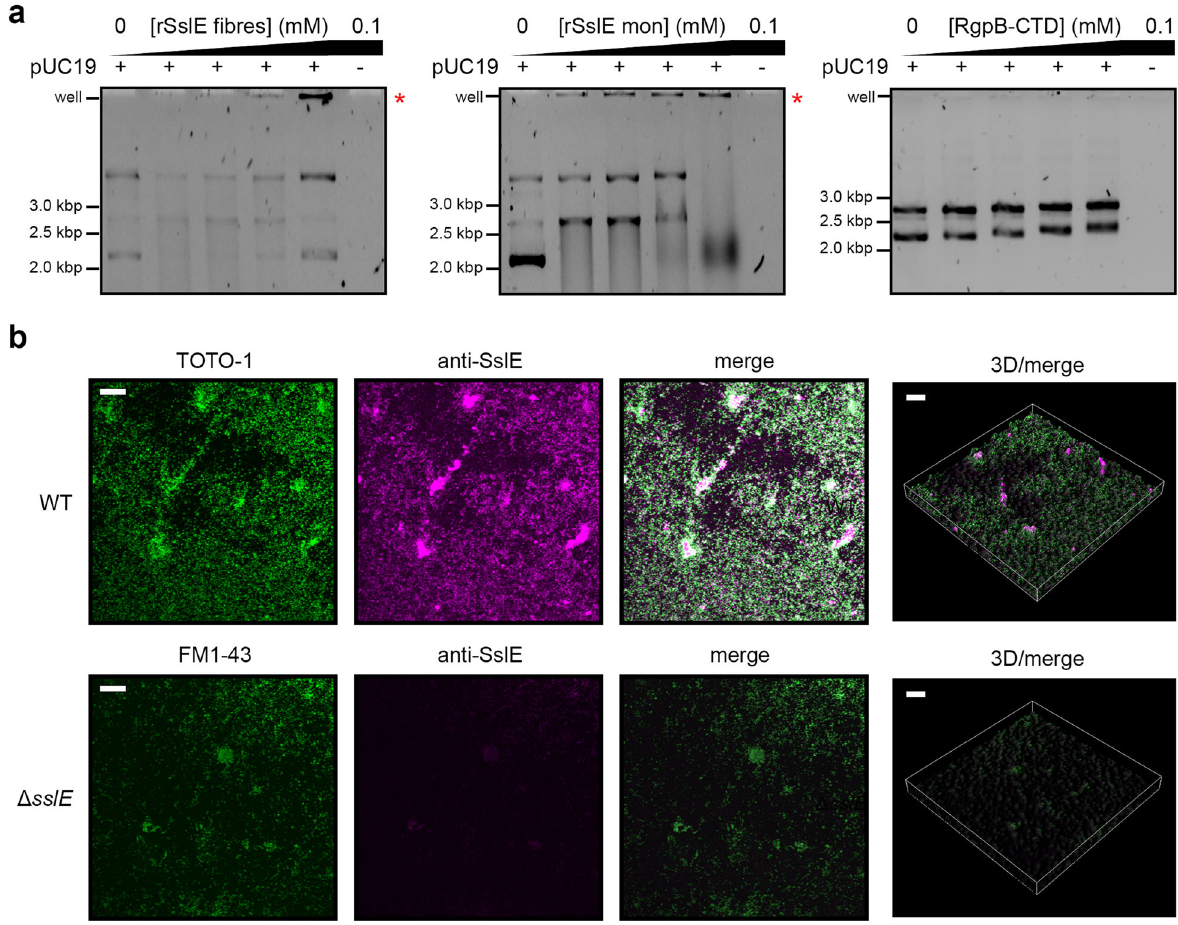
Fig. 7 SslE associates with eDNA in E. coli W bio fi lms. a Electrophoretic mobility shift assay of rSslE monomers and fi bres with pUC19 plasmid DNA substrate. P. gingivalis RgpB-CTD was used a negative control. Red asterisk (*) indicates the formation of a large protein – DNA complex retained in the wells. Gels were derived from the same experiment and processed in parallel. b Wild-type E. coli W bio fi lms were formed using a continuous fl ow cell system over 96 h. Immuno fl uorescence was performed where bio fi lms were incubated with α -rSslE antibodies followed by goat anti-rabbit conjugated Alexa Fluor 633 (magenta). Extracellular DNA and dead cells were stained with TOTO-1 (green). E. coli W Δ sslE strain was used as a control and again stained with α -rSslE/Alexa Fluor 633 (magenta) and the membrane dye FM 1 – 43 (green). Bio fi lms were visualised by CLSM. Scale bar is equivalent to 50 µm. All data are representative of at least three independent